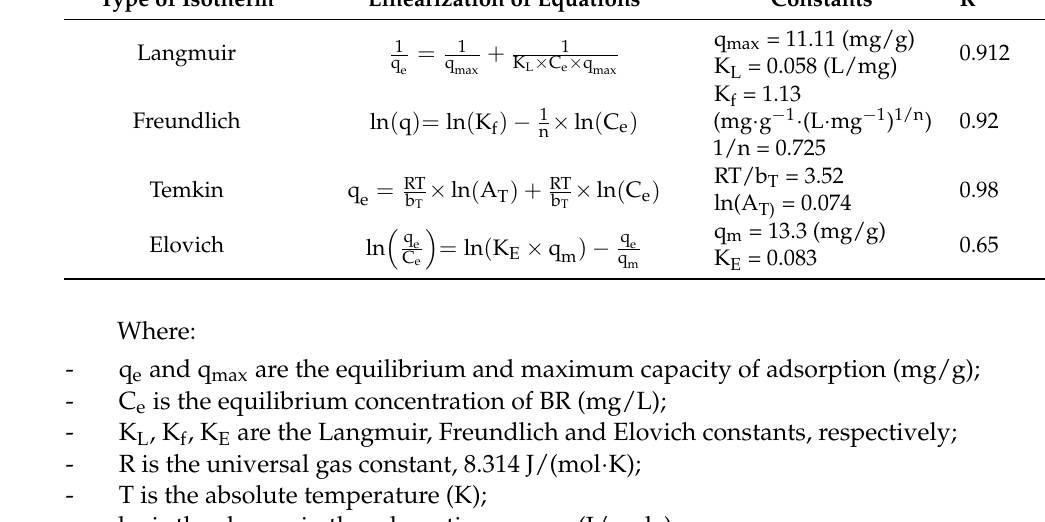
Table 6. Isotherm constant parameters for the adsorption of BR onto ALP. Type of